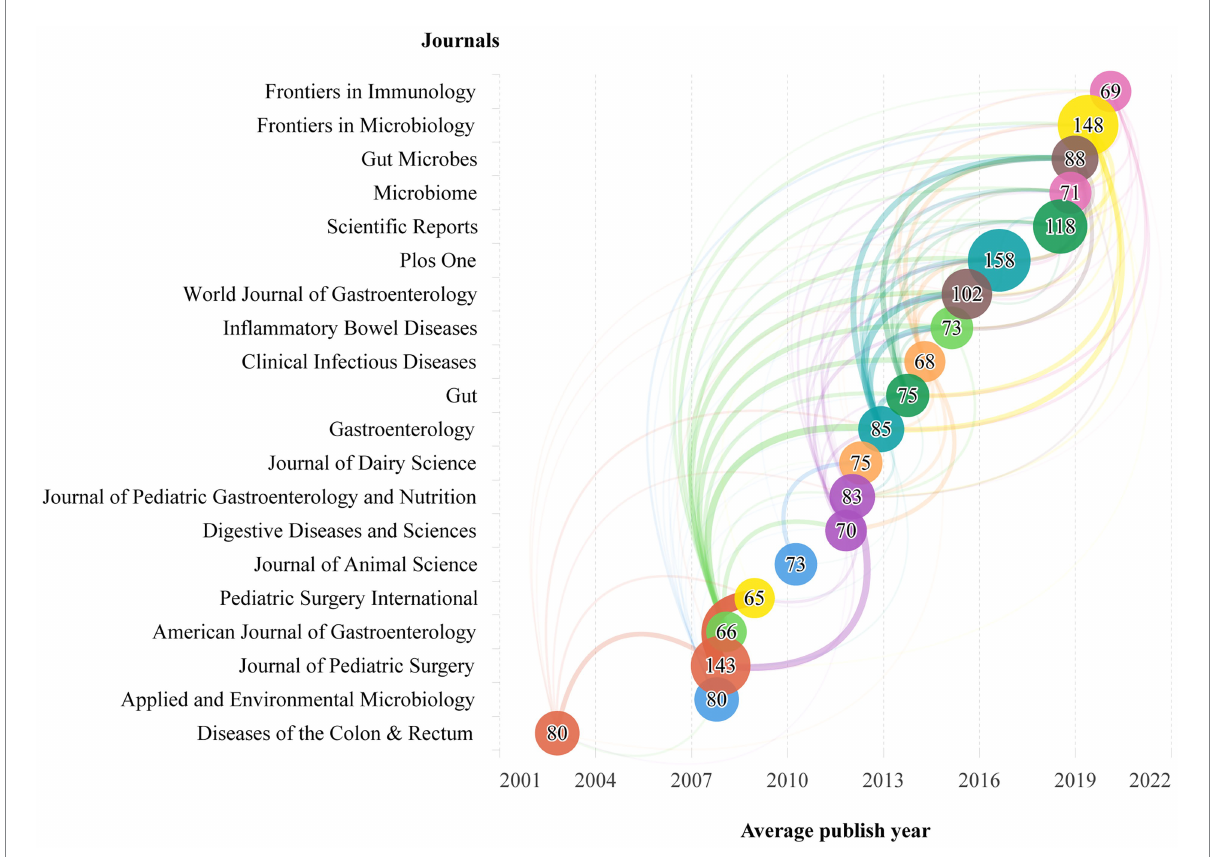
FIGURE 6 The average publish year of the top 20 journals with most publications. The size of the circle represents the total number of publications about FMT in different journals; the width of the lines between different journals represents the strength of cited each